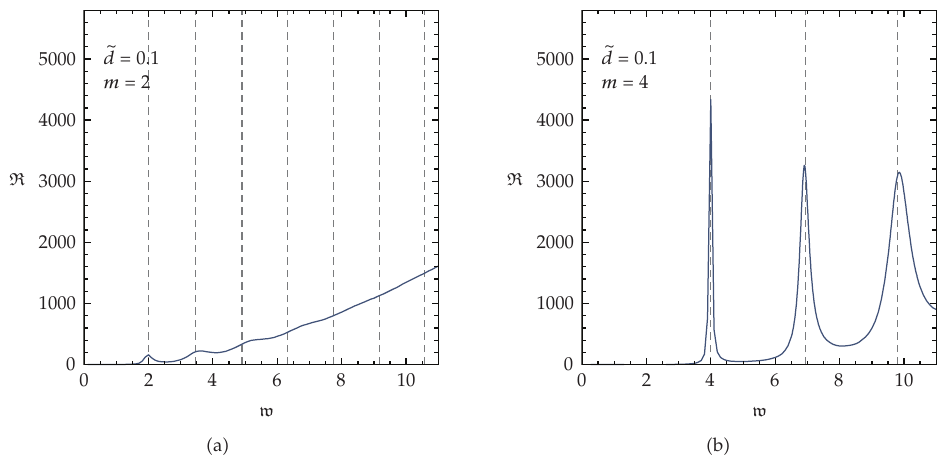
Figure 12: The dependence of the spectra on quark mass. The dashed lines again mark the supersymmetric